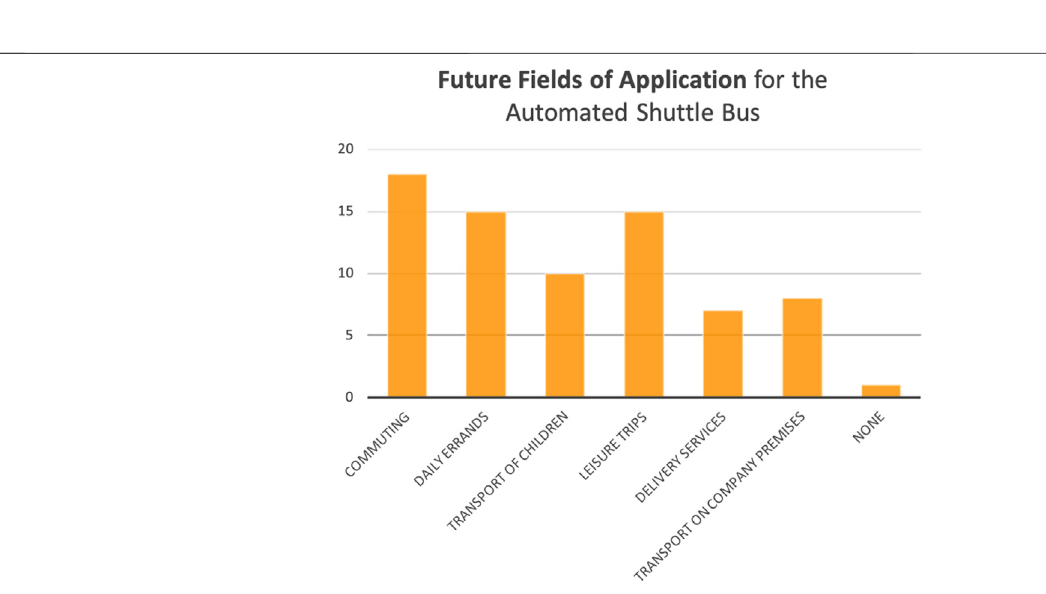
Frontiers in Human Dynamics |